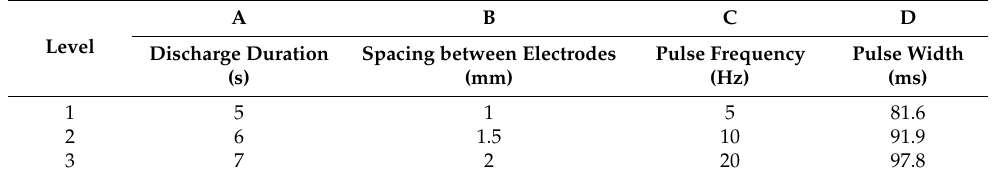
Table 2. Impact factors and their levels.